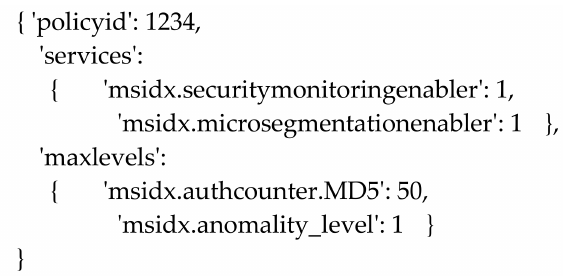
Figure 8. A trust model